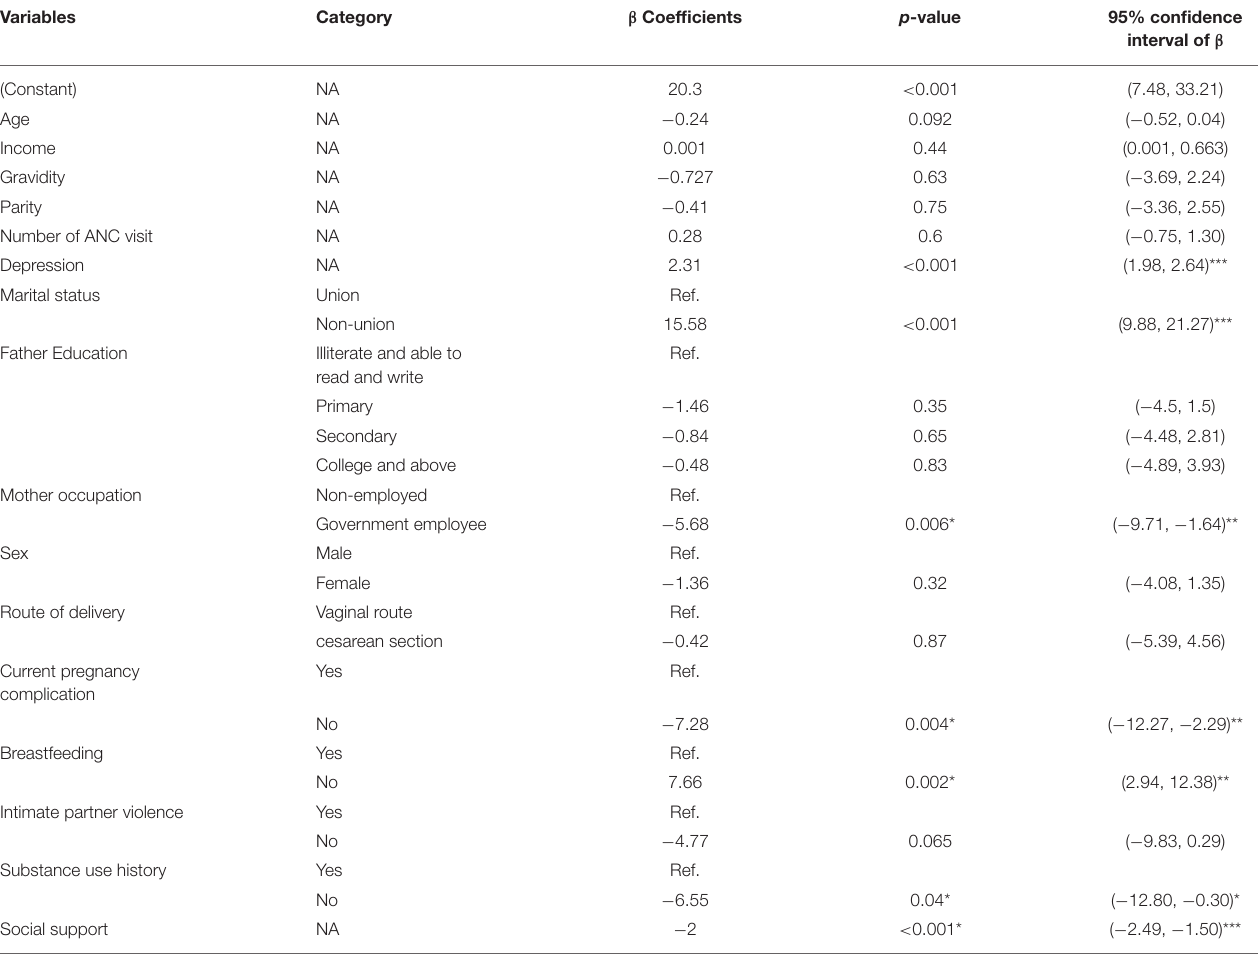
TABLE 6 | Multivariable distribution of mother-infant bonding among post-natal mothers by key predictors in Debre Tabor Town, Northwest Ethiopia, 2021.